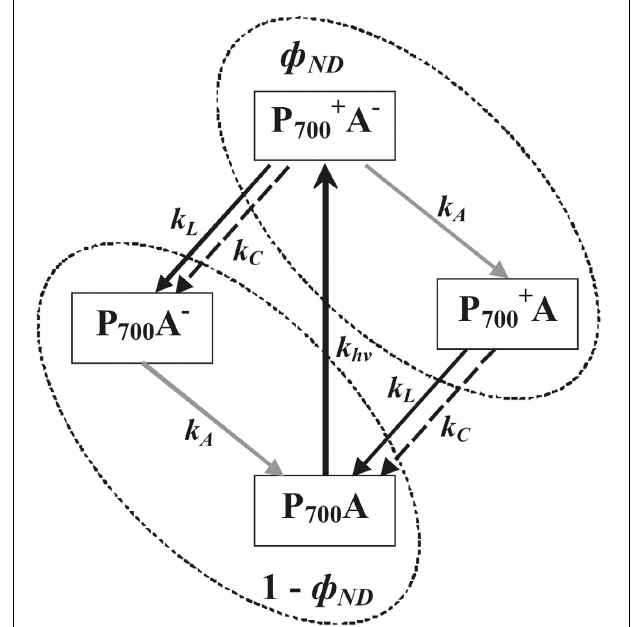
FIGURE 9 | A simple schema of PSI states, based on Klughammer and Schreiber (1994) and Vredenberg and Bulychev (2010). P + 700 and P 700 , oxidized and reduced forms of primary electron donor in PSI, respectively; A and A − , oxidized and reduced forms PSI acceptor, respectively; (cid:2) (cid:3) 1 − dII , velocity constant of parameter k hv = γ × PFD × p × light-dependant P 700 oxidation, with γ , proportionality coefficient; (cid:4) (cid:4) (cid:5) (cid:5) PC − and k C = k PC × PC − , velocity constants parameters k L = k PC × L C of electron flow through PS II (mainly noncyclic) and cyclic electron flow, respectively; k PC , velocity constant of plastocyanin oxidation by P + 700 ; [PC − ] L , concentration of reduced plastocyanin, participating in flow through PS II; [PC − ] C , concentration of reduced plastocyanin, participating in cyclic flow; k A , velocity constant of PSI acceptor side oxidation being connected with cyclic, noncyclic and pseudocyclic flows; φ ND , portion of P + 700 A − and P + 700 A (Klughammer and Schreiber, 2008); and 1 - φ ND , portion of P 700 A − and P 700